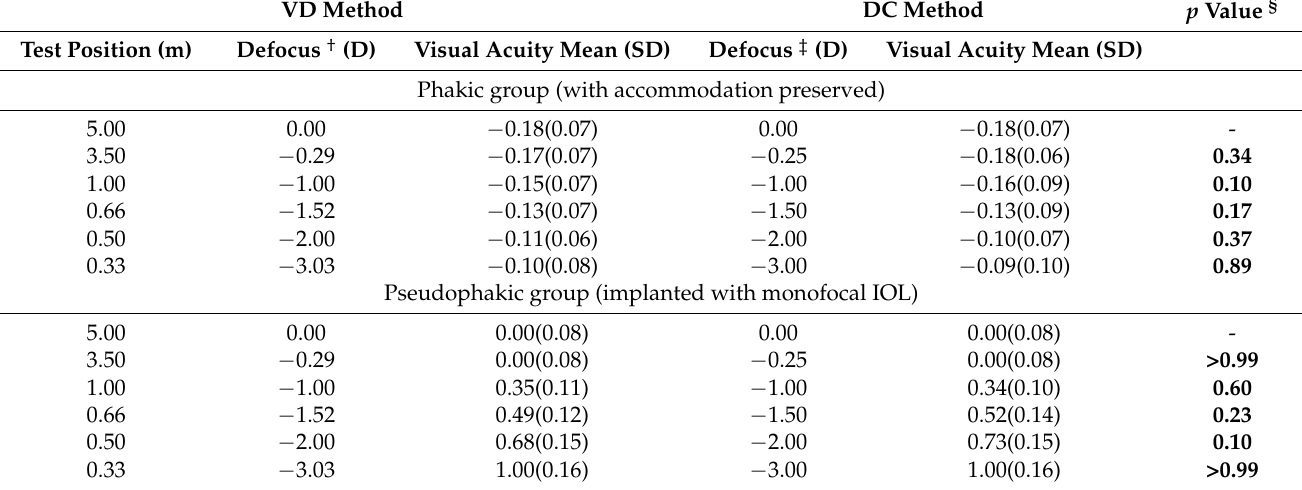
Table 1. Visual acuity (mean (SD), uncorrected results) that was obtained with the VD and DC methods in the phakic and pseudophakic groups. The measurements were taken with the best distance correction. The accommodative stimulus of 3.5 m is rounded from 0.285 D to 0.29 D. p values > 0.05 appear